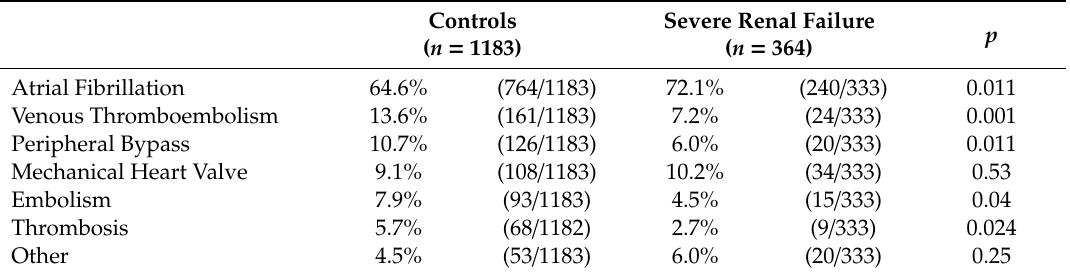
Table 2. Indication for oral anticoagulation comparing patients with severe renal failure and controls managed in usual medical